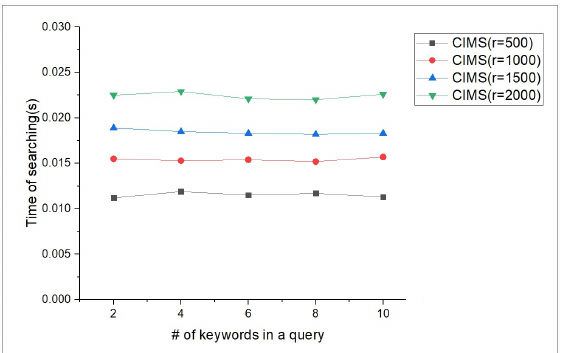
Figure 8. Search time while changing the number of keywords in a